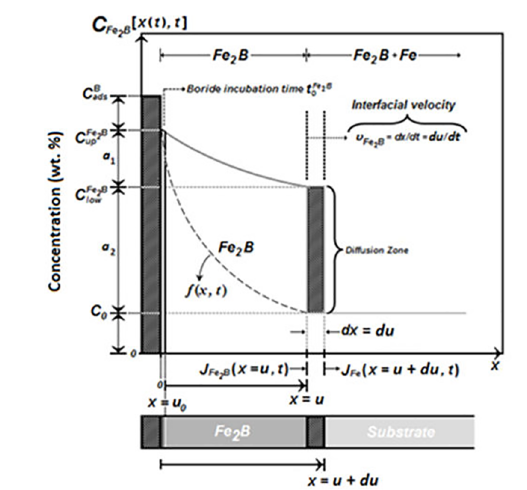
Figure 1. Schematic representation of the boron-concentration profile through the Fe B 2